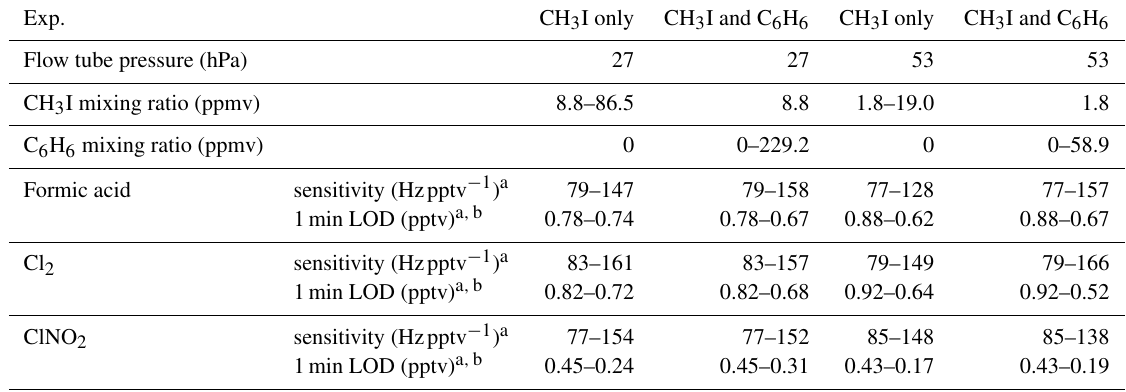
Table 1. Experiment conditions, sensitivities, and limits of detection (LODs) for VUV-IS configuration (b). Exp.